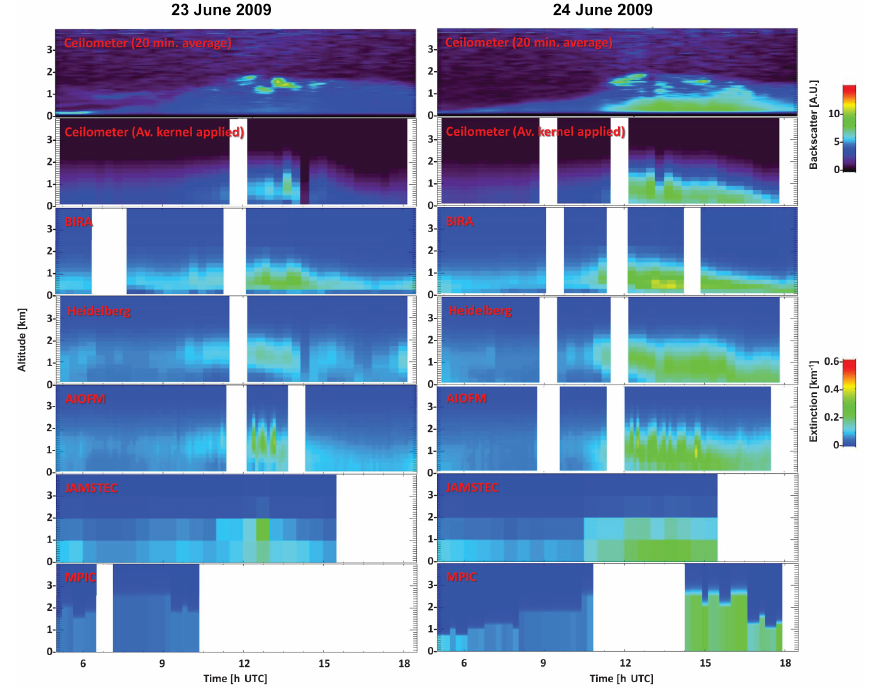
Figure 4. Comparison of MAX-DOAS extinction profiles with backscatter profiles from the ceilometer for 23 June (left) and 24 June (right). The top panel shows the backscatter signal in original vertical resolution, the second panel the backscatter signal with the averaging kernels of Heidelberg applied, and below that the extinction profiles retrieved from BIRA, Heidelberg, JAMSTEC, and MPIC. For MPIC box-profiles with the retrieved layer height and AOT are plotted.